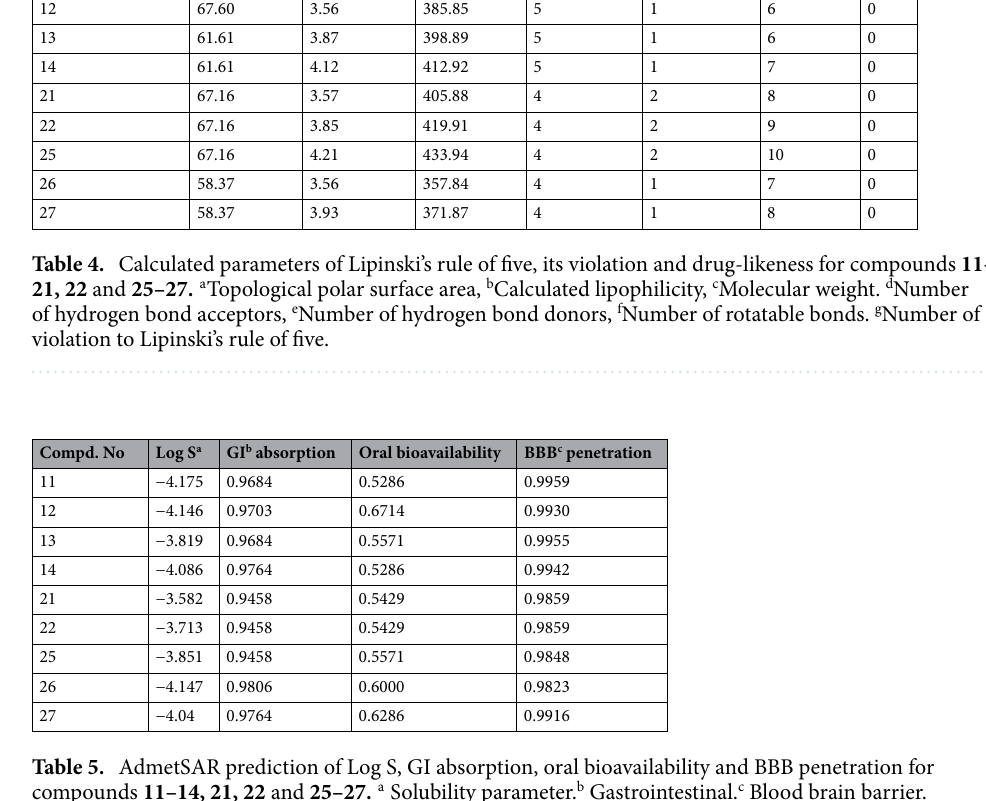
Table 5. AdmetSAR prediction of Log S, GI absorption, oral bioavailability and BBB penetration for compounds 11–14, 21, 22 and 25–27. a Solubility parameter. b Gastrointestinal. c Blood brain barrier.